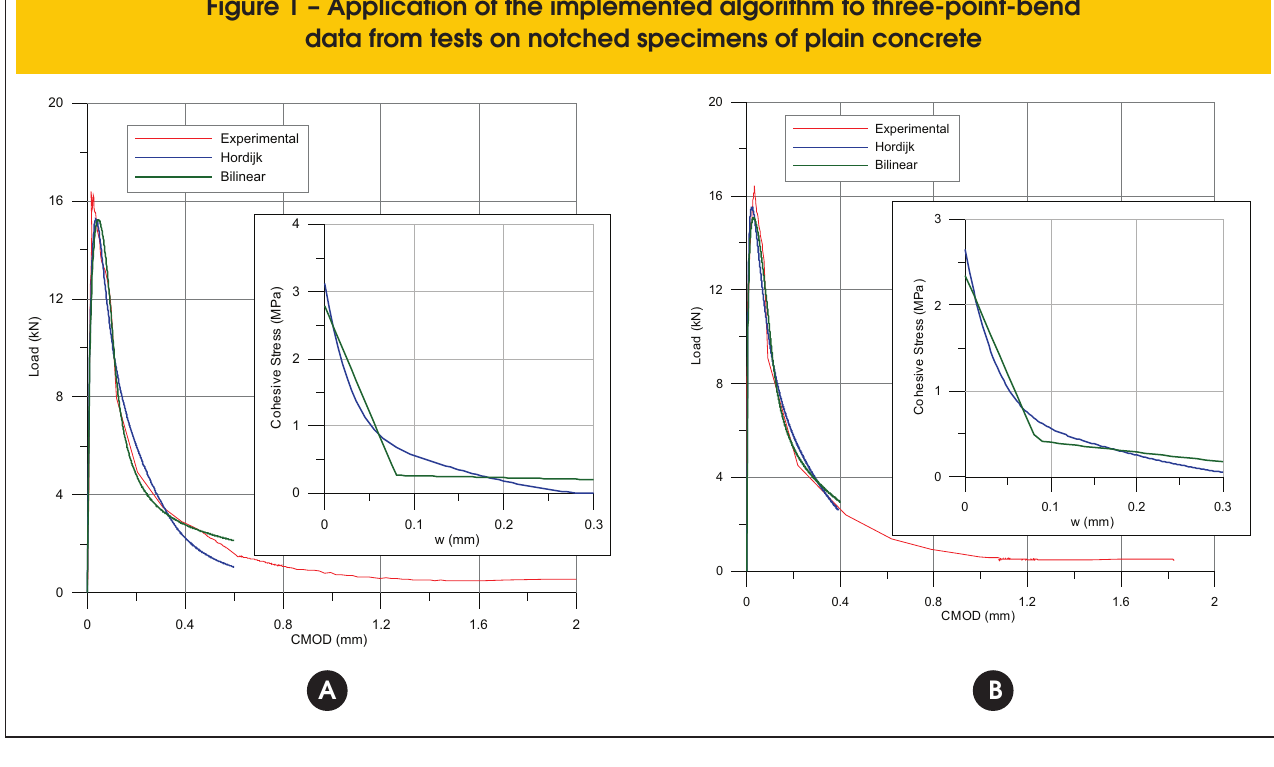
Figure 1 – Application of the implemented algorithm to three-point-bend data from tests on notched specimens of plain concrete